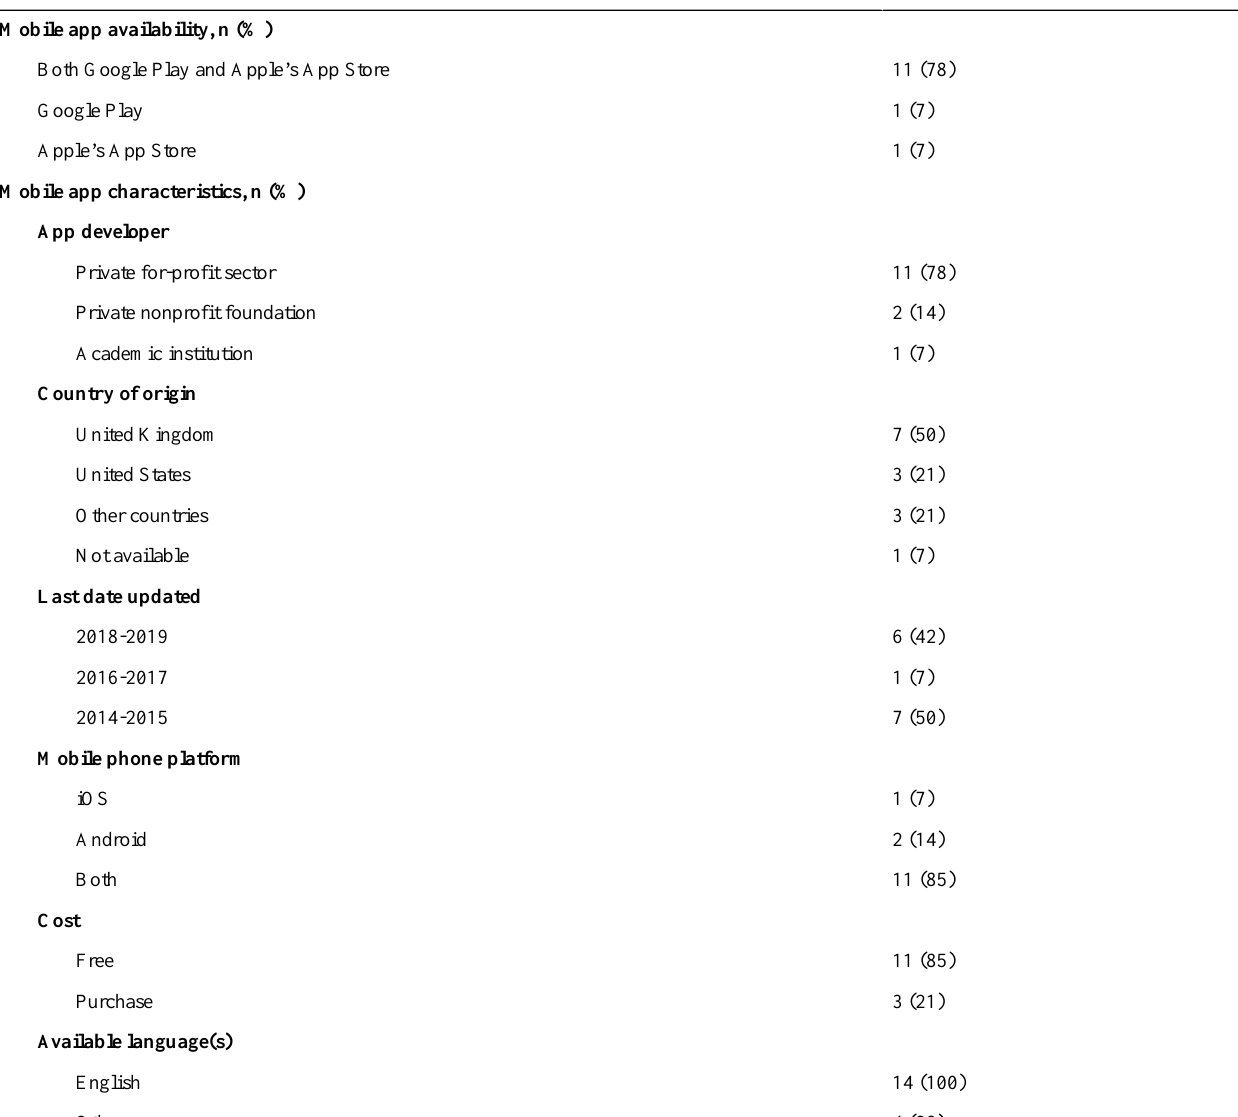
Table 1. App availability, readability, characteristics, and features. ValuesApp availability, readability, characteristics, and